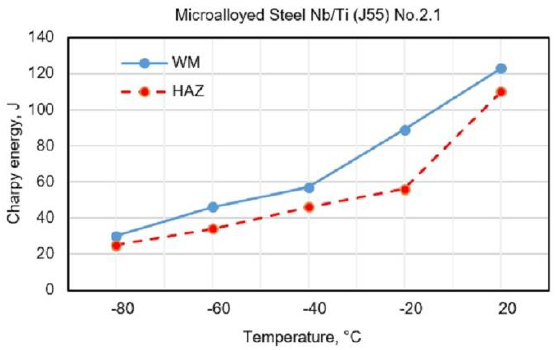
Figure 4. Test results of impact energy at test temperatures of welded joints made with electrode No.1.2.